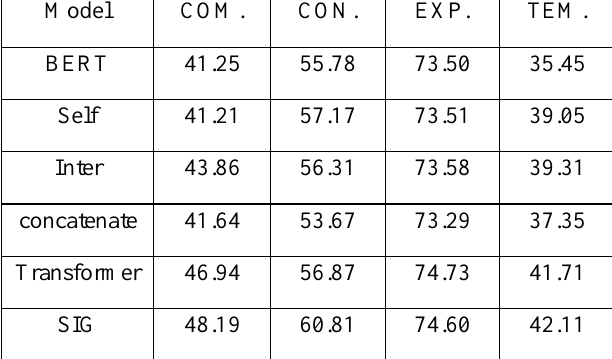
Table 2. Classification results of four categories of discourse relations by different models/%